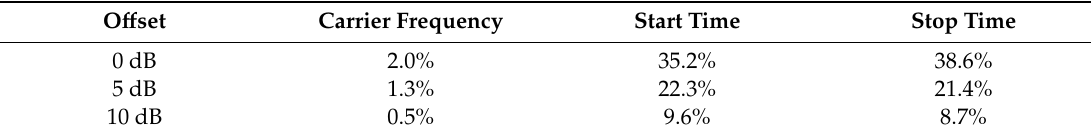
Table 2. The offset in the estimation of the various parameters.